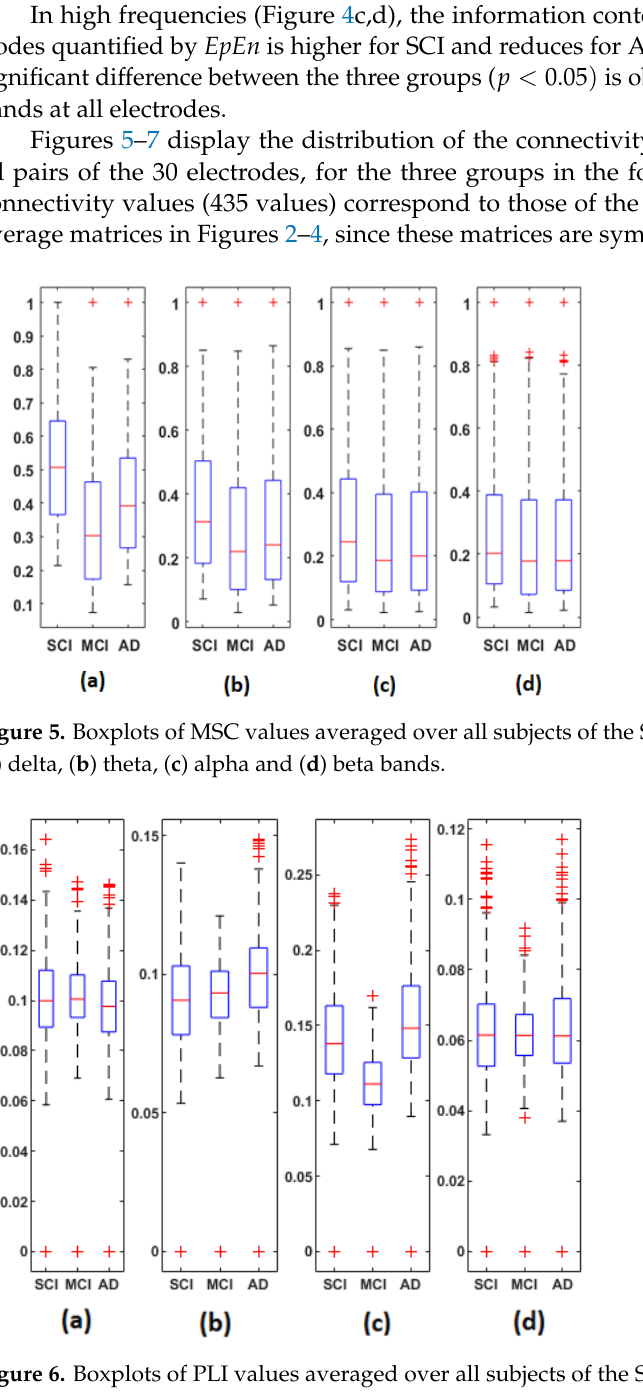
Figure 6. Boxplots of PLI values averaged over all subjects of the SCI, MCI and AD groups on the ( a ) delta, ( b ) theta, ( c ) alpha and ( d ) beta